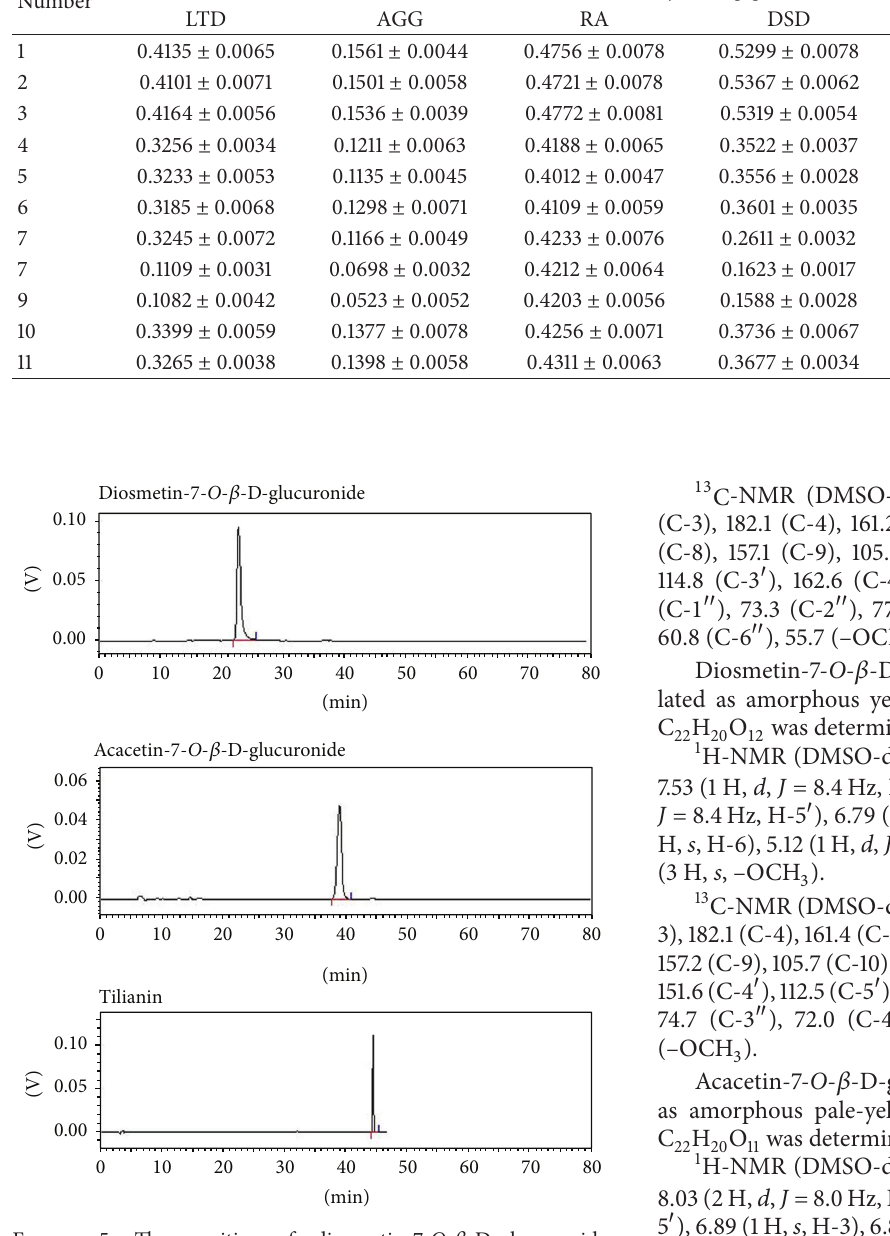
NMR Data of Tilianin, Diosmetin-7-O- 𝛽 -D-glucuronide, and Acacetin-7-O- 𝛽 -D-glucuronide . Tilianin (TLN) [23] was iso- lated as amorphous pale-yellow powder. Its molecular for- H O 10 was determined by ESI-MS at 𝑚/𝑧 445 mula C 22 20 [ M-H ] − .